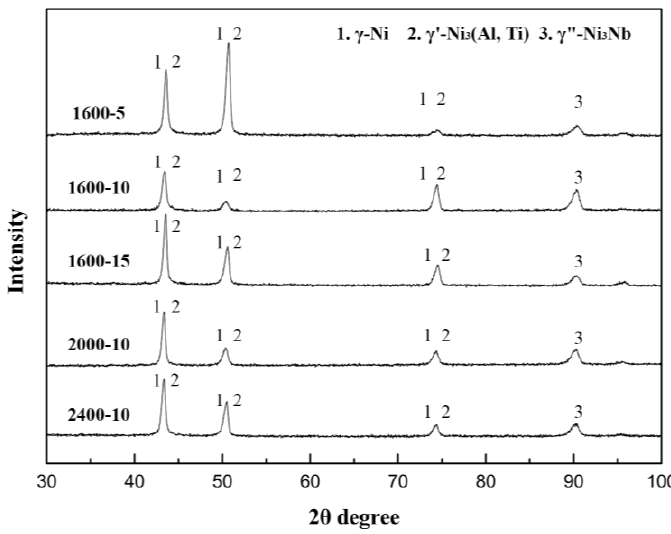
Figure 3. XRD spectra of IN718 coating under different process parameters.